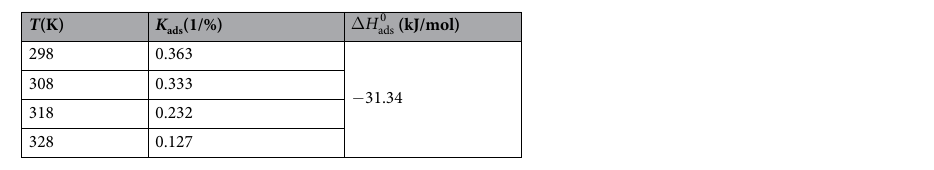
Table 5. The thermodynamic parameters for mild steel in 0.5 M H 2 SO 4 solution containing different V/V concentrations of LLE at different